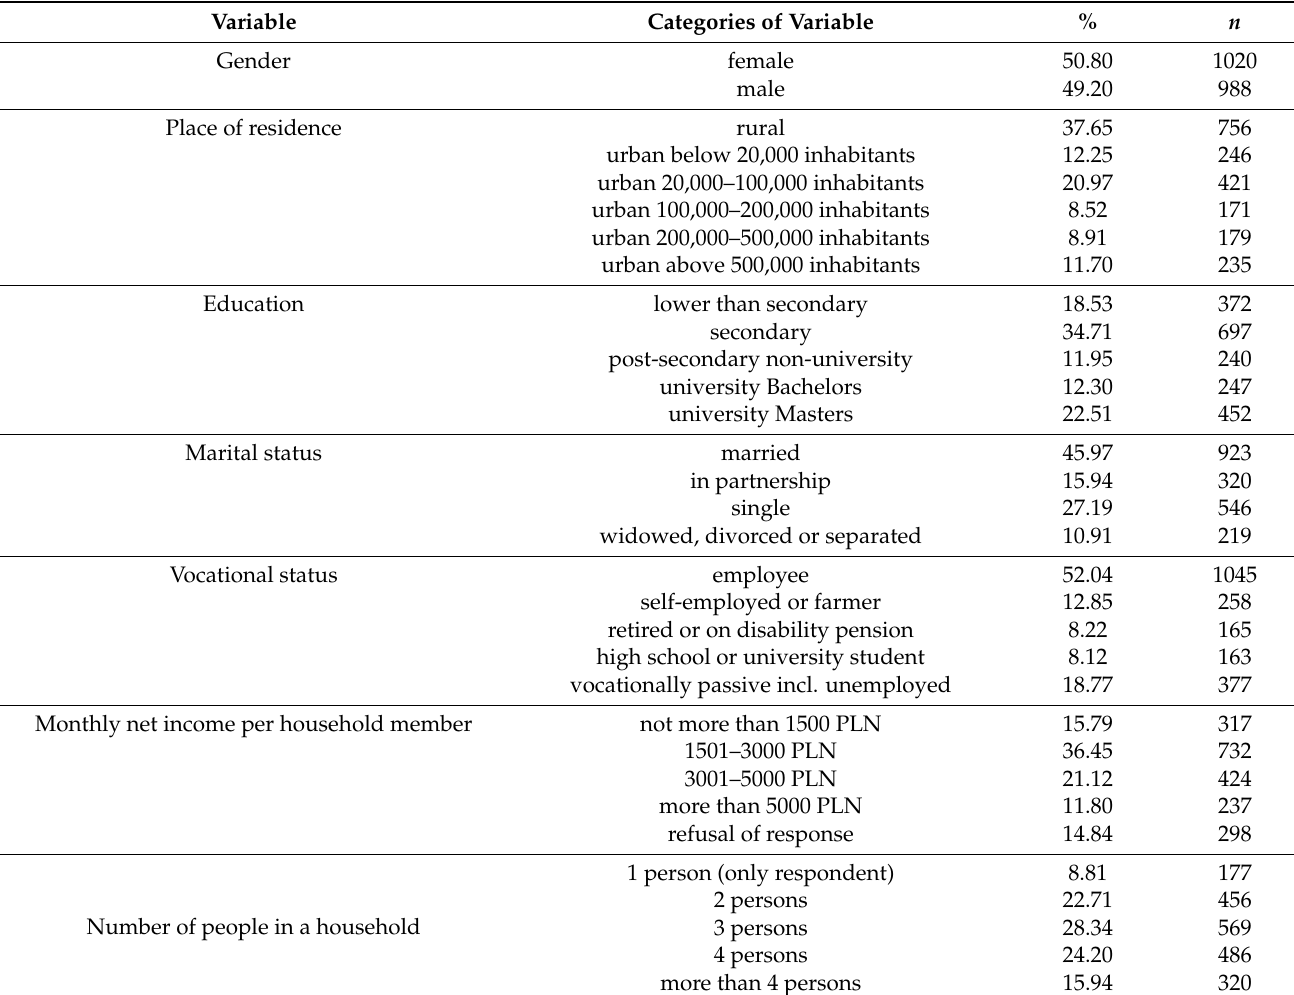
Table 1. Characteristics of the study